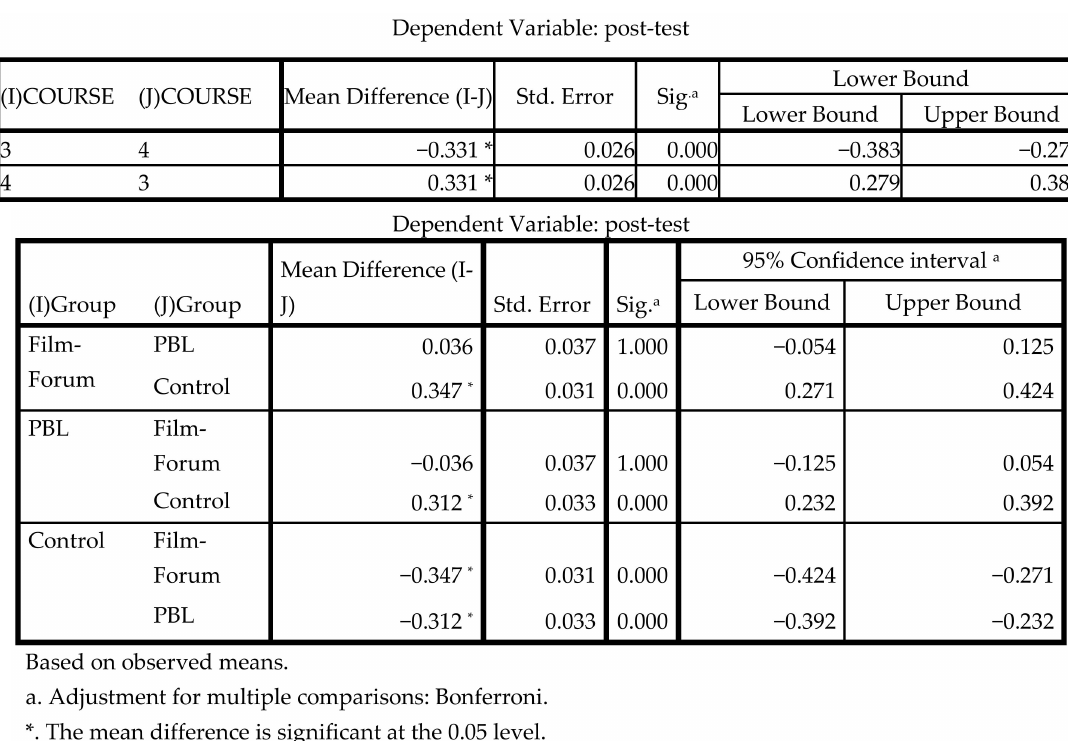
Figure 4. Comparison by course and group.